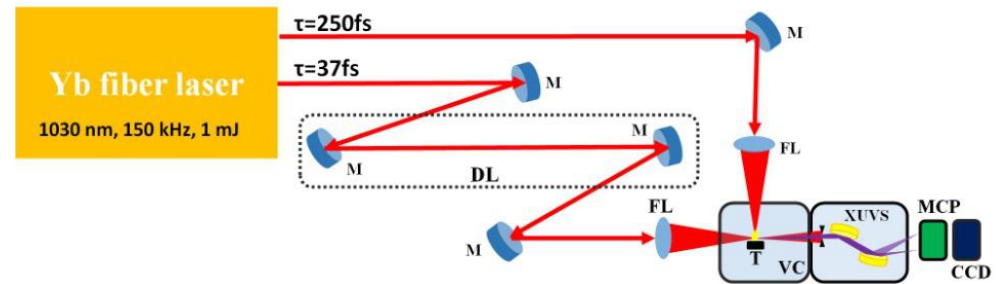
Figure 1. Experimental scheme. Yb fiber laser, ytterbium-doped fiber chirped pulse amplification laser; M, mirrors; DL, delay line; FL, focusing lenses; VC, vacuum chamber; T, target; XUVS, extreme ultraviolet spectrometer; MCP, microchannel plate; CCD, CCD camera.